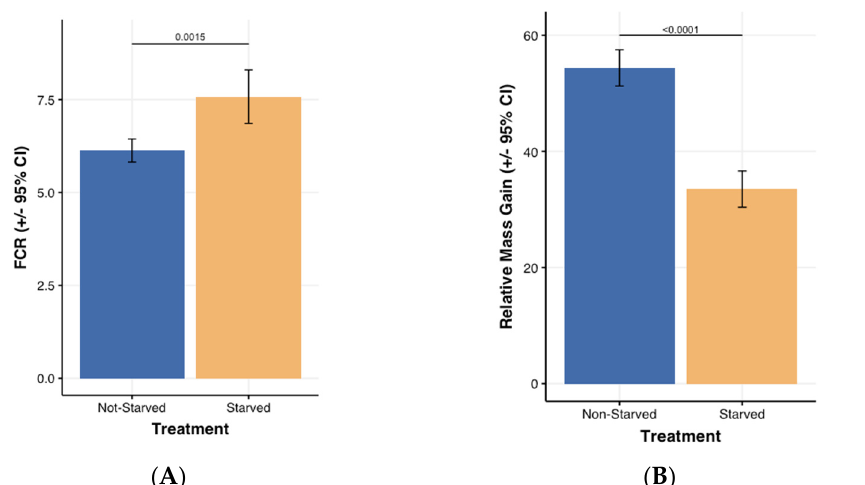
Figure 3. ( A , B ) respectively, represent FCR (Feed Conversion Ratio) and the relative mass gain expressed as a percentage and as a function of starvation after 24 days.